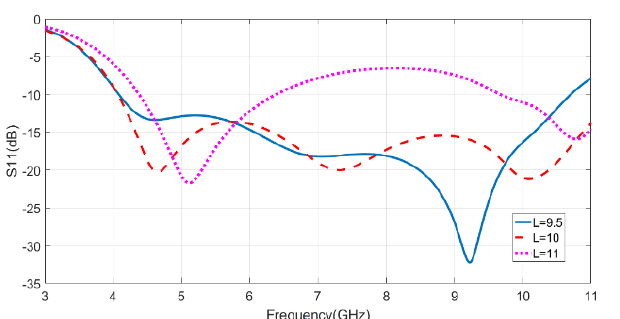
Figure5: Simulated reflection coefficient for various length of ground L .